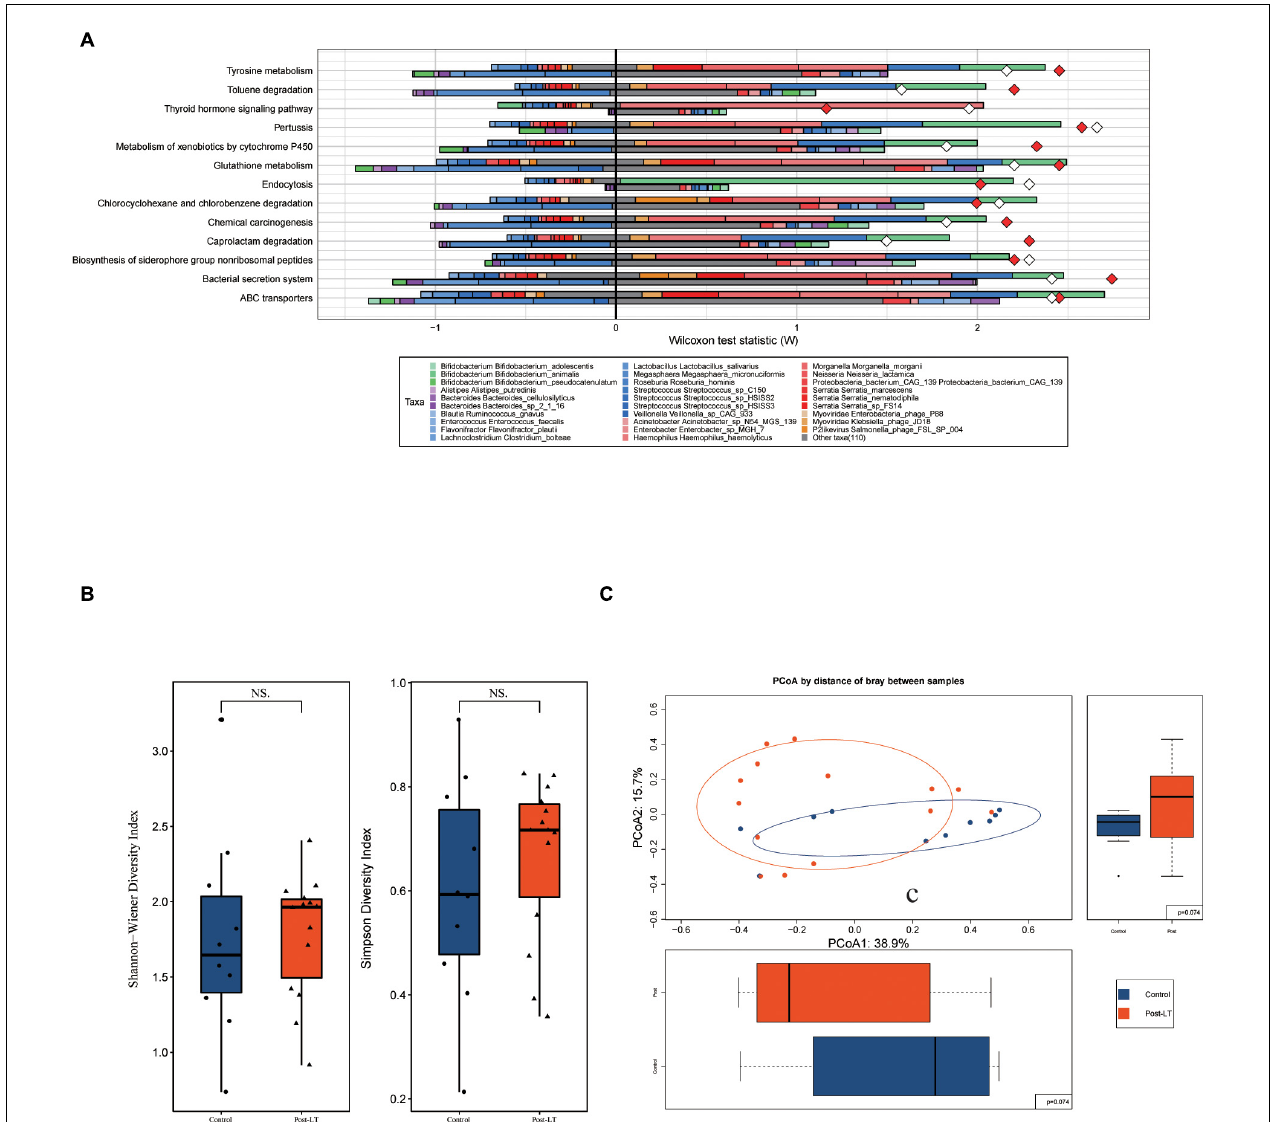
FIGURE 4 | (A) Fishtaco analysis of species contribution to metabolic pathways between the pre-LT and post-LT groups. The x -axis represents the Wilcoxon test statistic scores, and the y -axis the related functions. The driving factors for each differential function transformation were divided into four parts, represented by a histogram in two directions. Gut microbiota in the pre-LT group that drove the increase in the corresponding functional abundance (top right); Gut microbiota in the pre-LT group that inhibited the increase in the corresponding functional abundance (top left); Gut microbiota in the post-LT group that drove the increase in the corresponding functional abundance (bottom right); and gut microbiota in the post-LT group that inhibited the increase in the corresponding functional abundance (bottom left). Different color bars represent the corresponding species. The longer the bar, the greater the driving or inhibiting effect of the species on the corresponding function. (B) Alpha diversity between the post-LT and control groups (box plot of richness, Shannon–Wiener Index, and Simpson Index). (C) Beta diversity between the post-LT and control groups (principal coordinate analysis based on the Bray–Curtis distance of species